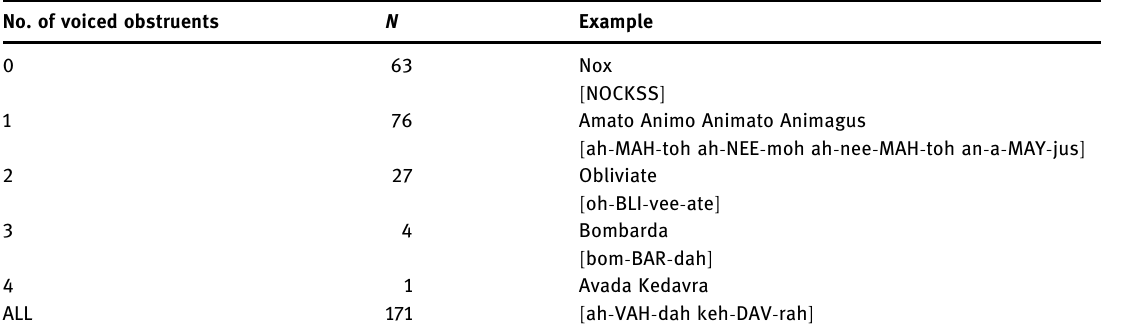
No. of voiced obstruents